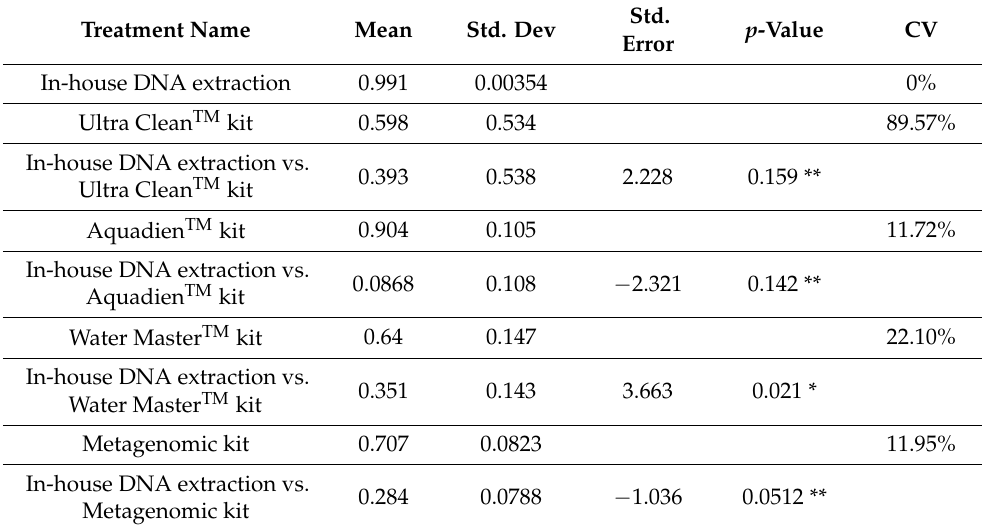
Table 4. Statistical comparison between in-house DNA extraction method versus commercial water- testing